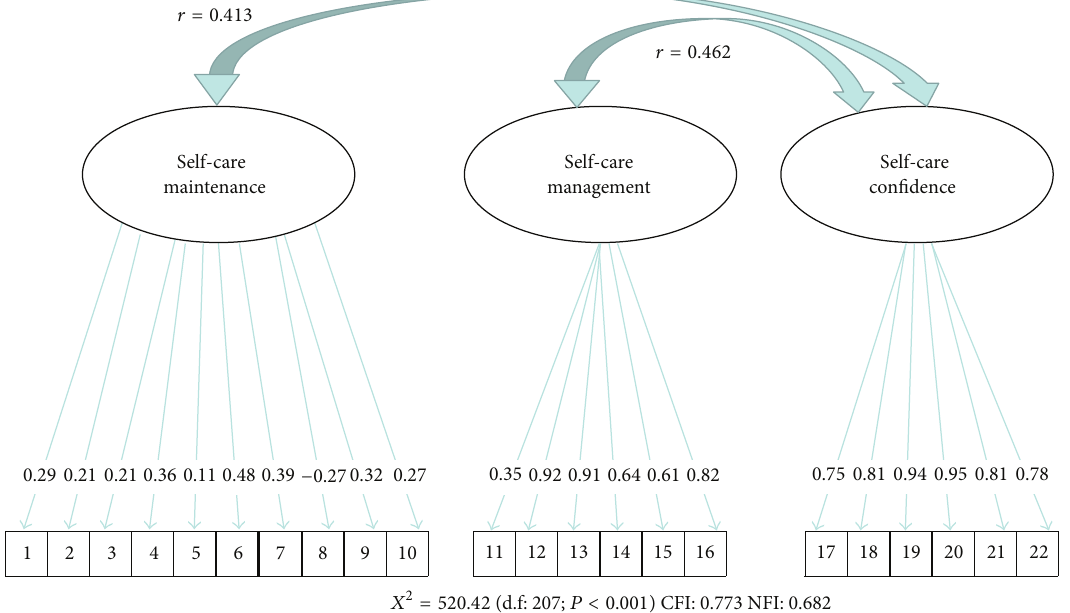
Figure 1: Confirmatory factor analysis. The figure shows the standardized loadings for the indicators of the latent constructs of the self-care maintenance, self-care management, and Self-Care Confidence scales. Numbers within the outlined boxes represent item numbers. Numbers outside the outlined boxes represent the factor loadings. The negative loading of item 8 is due to its reverse scoring. 𝑟 represents correlations between the self-care maintenance and self-care confidence/self-care management and self-care confidence scales.